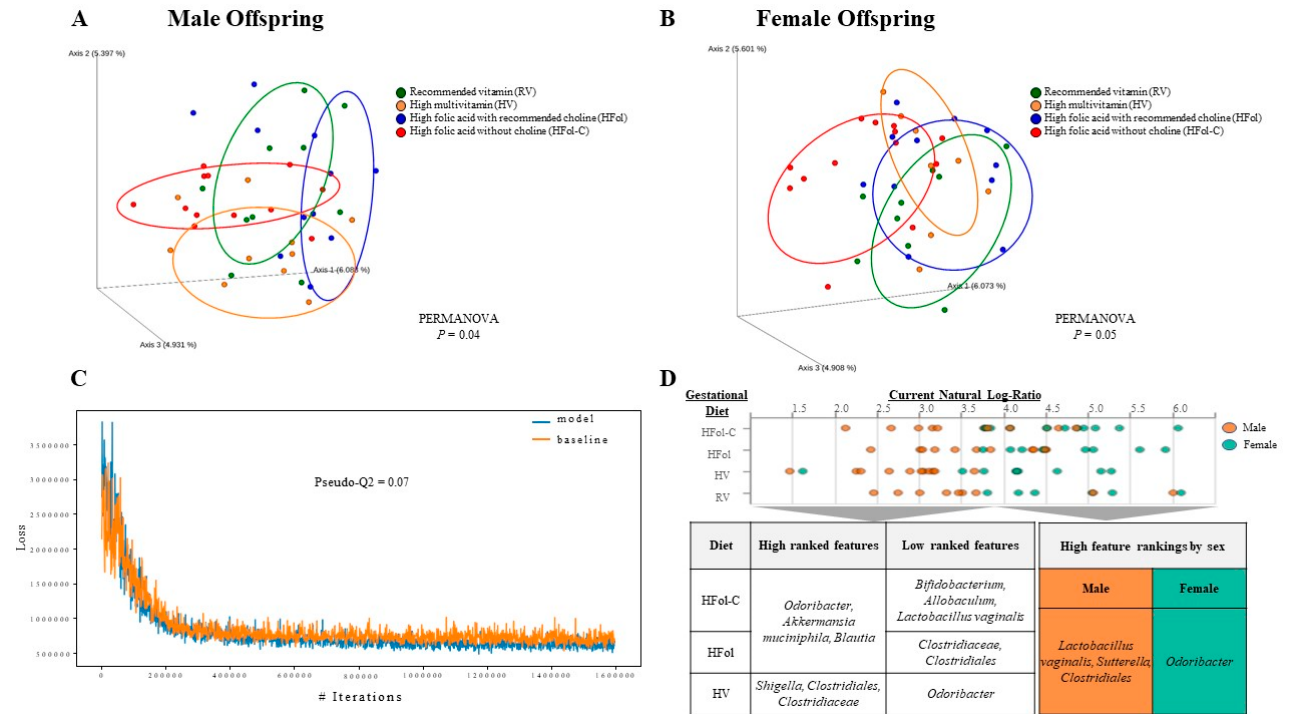
Figure 7. A principal coordinates analysis (PCoA) of the unweighted UniFrac distances in ( A ) male and ( B ) female offspring at 12 weeks post-weaning. Diet abbreviations: RV, recommended vitamin; HV, high multivitamin; HFol, high folic acid with recommended choline; HFol-C, high folic acid without choline. Gut microbiota composition differed among the diet groups in male ( p = 0.04, n = 10–11/group) and female ( p = 0.05, n = 10–11/group) offspring by PERMANOVA with 999 permutations via the adonis function. ( C ) Comparison of the Songbird multinomial regression model with diet and sex as covariates against a baseline model (pseudo-Q2 value = 0.07). ( D ) Differential log-ratios explored as high and low ranked features (top to bottom 10% of features) associated with diet and sex as visualized with Qurro.